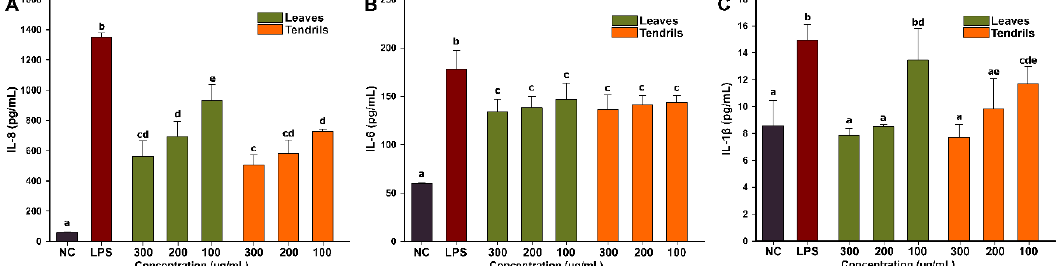
Figure 4. The extracellular release of proinflammatory cytokines IL-8 ( A ), IL- 6 ( B ), and IL-1 β ( C ) was analyzed in cell-free supernatants by ELISA at 24 h post-exposure to three concentrations of the LE and TE in combination with 100 ng/mL LPS. The values are expressed as mean ± standard deviation (SD) of four biological replicates. Different letters (a – e) represent the significant differences in mean quantities of cytokines measured (ANOVA + Holm-Sidak post hoc test at p < 0.05 level of significance). Showing significant anti-inflammatory properties, bioactive compounds from natural sources have received an increased attention for the management of various inflammatory-related diseases.